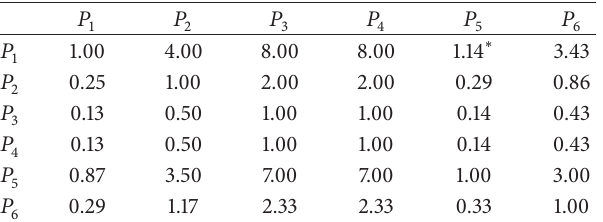
Table 12: Solution matrix of alternatives by the proposed approach (Example 2).